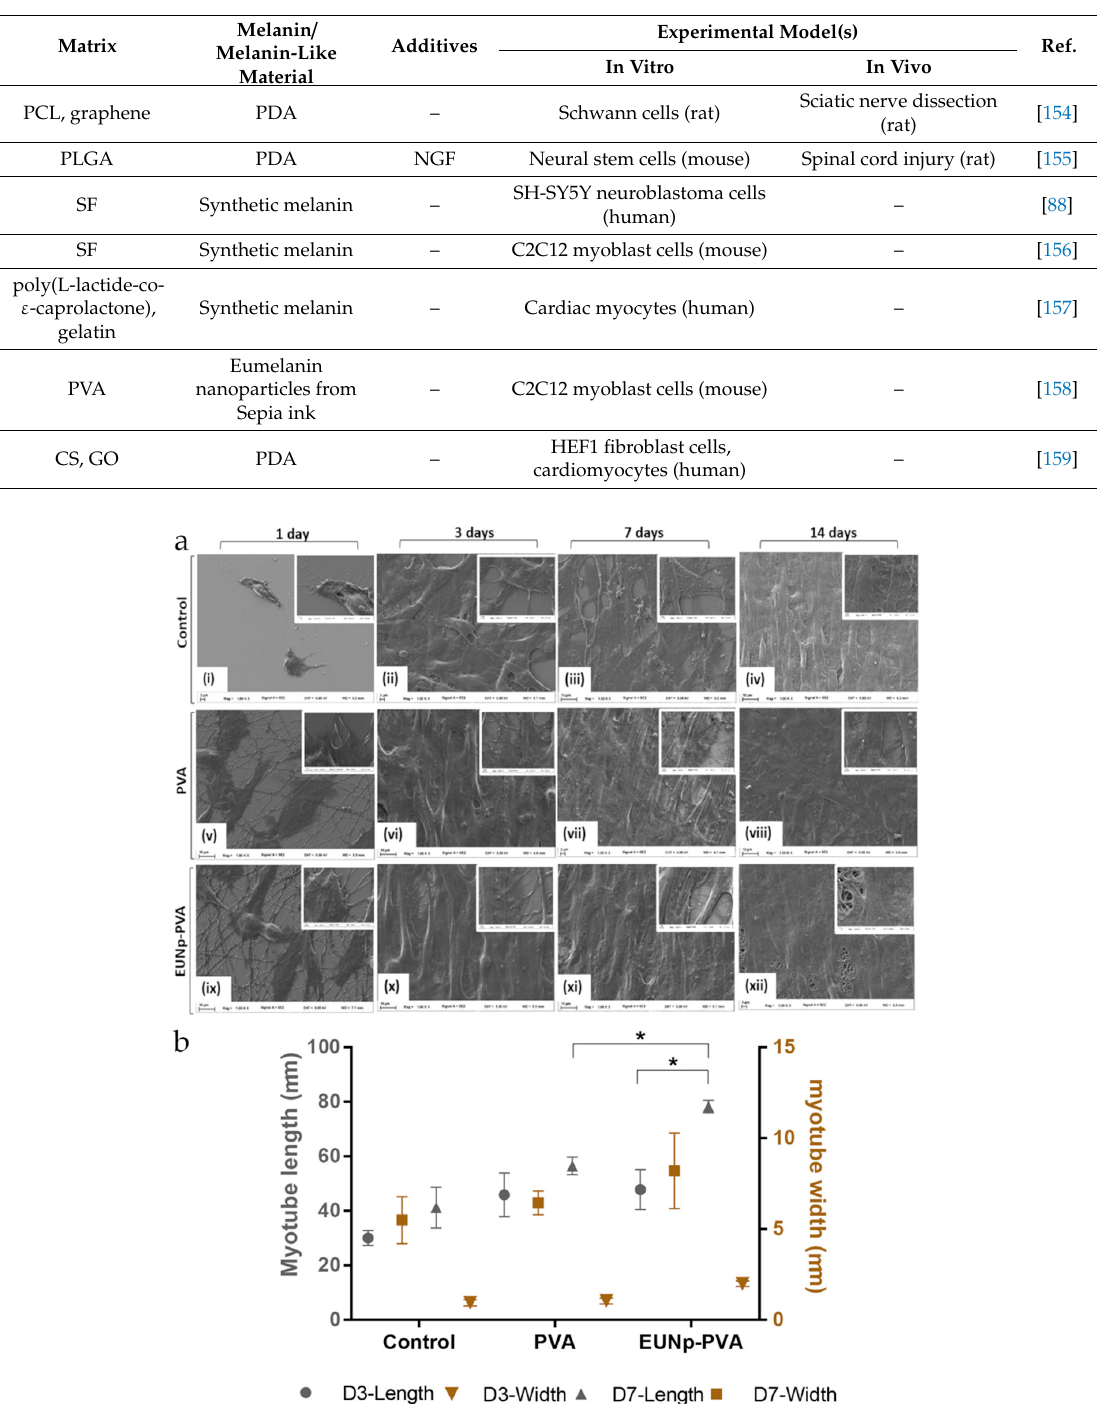
Figure 17. ( a ) Myogenic differentiation of C2C12 on nanofibrous scaffolds. SEM micrographs of myoblasts represent the control ( i ), polyvinyl alcohol (PVA) ( v ), and eumelanin nanoparticles-PVA ( ix ) at day 1; control ( ii ), PVA ( vi ), and eumelanin nanoparticles-PVA ( x ) at day 3; control ( iii ), PVA ( vii ), and eumelanin nanoparticles-PVA ( xi ) at day 7; and control ( iv ), PVA ( viii ), and eumelanin nanoparticles-PVA ( xii ) at day 14. ( b ) Quantification of myotube formation during differentiation of C2C12 on PVA, and eumelanin nanoparticles-PVA nanofibrous scaffolds and respective controls at day 3 and day 7. (* p < 0.05). Reproduced with permission from [158]. Copyright American Chemical Society, 2018.